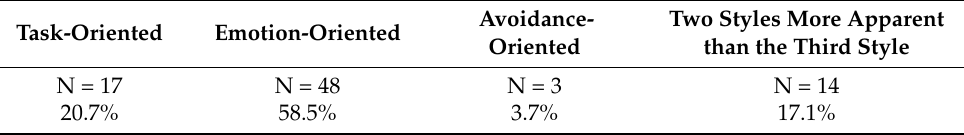
Table 5. Styles of coping with stressful situations (based on CISS).